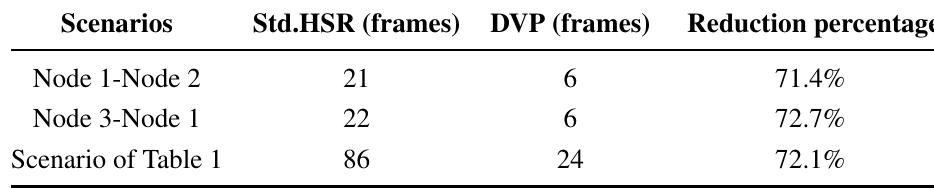
Table 2. Network traffic comparison between the standard HSR protocol and DVP algorithm under the failure-free case.